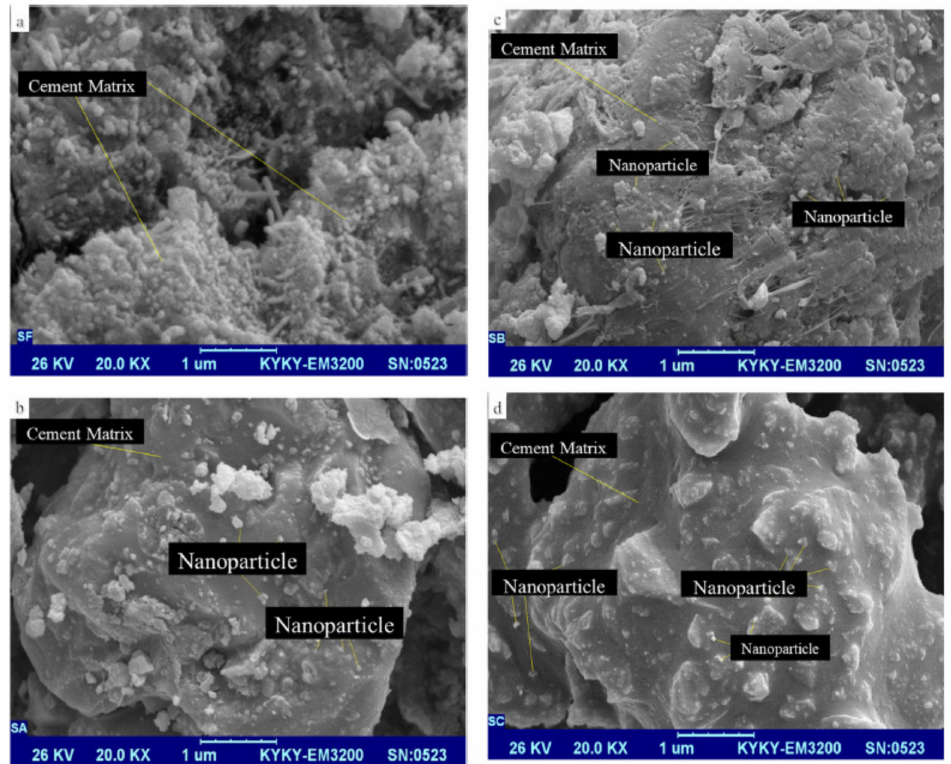
Figure 10. Scanning electron microscopy images of cement composites with: ( a ) 0.0 wt %, ( b ) 2.0 wt %, ( c ) 4.0 wt %, and ( d ) 6.0 wt % of ferric oxide nanoparticles. Reproduced from